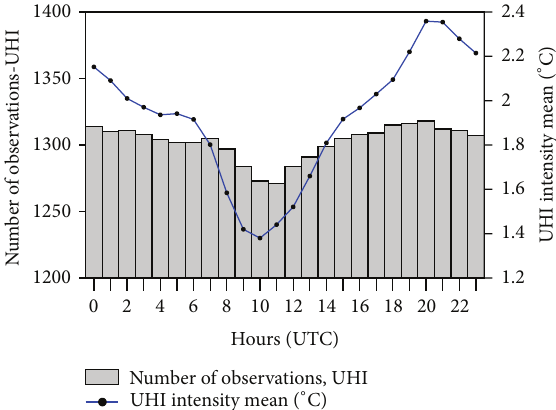
Figure 7: UHII (hourly means) in the period